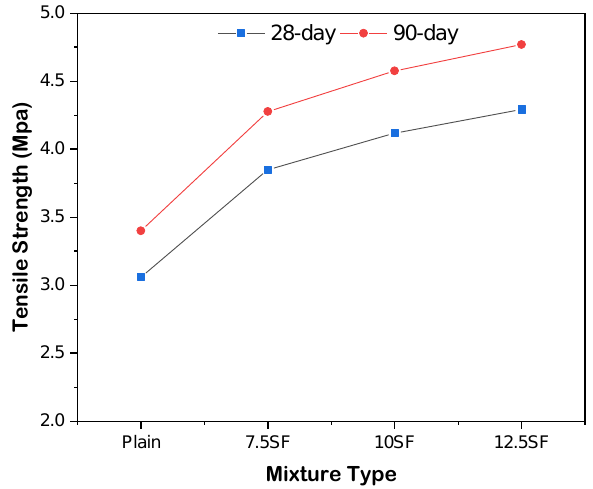
Figure 8. Tensile Strength of concrete mixed with SF.